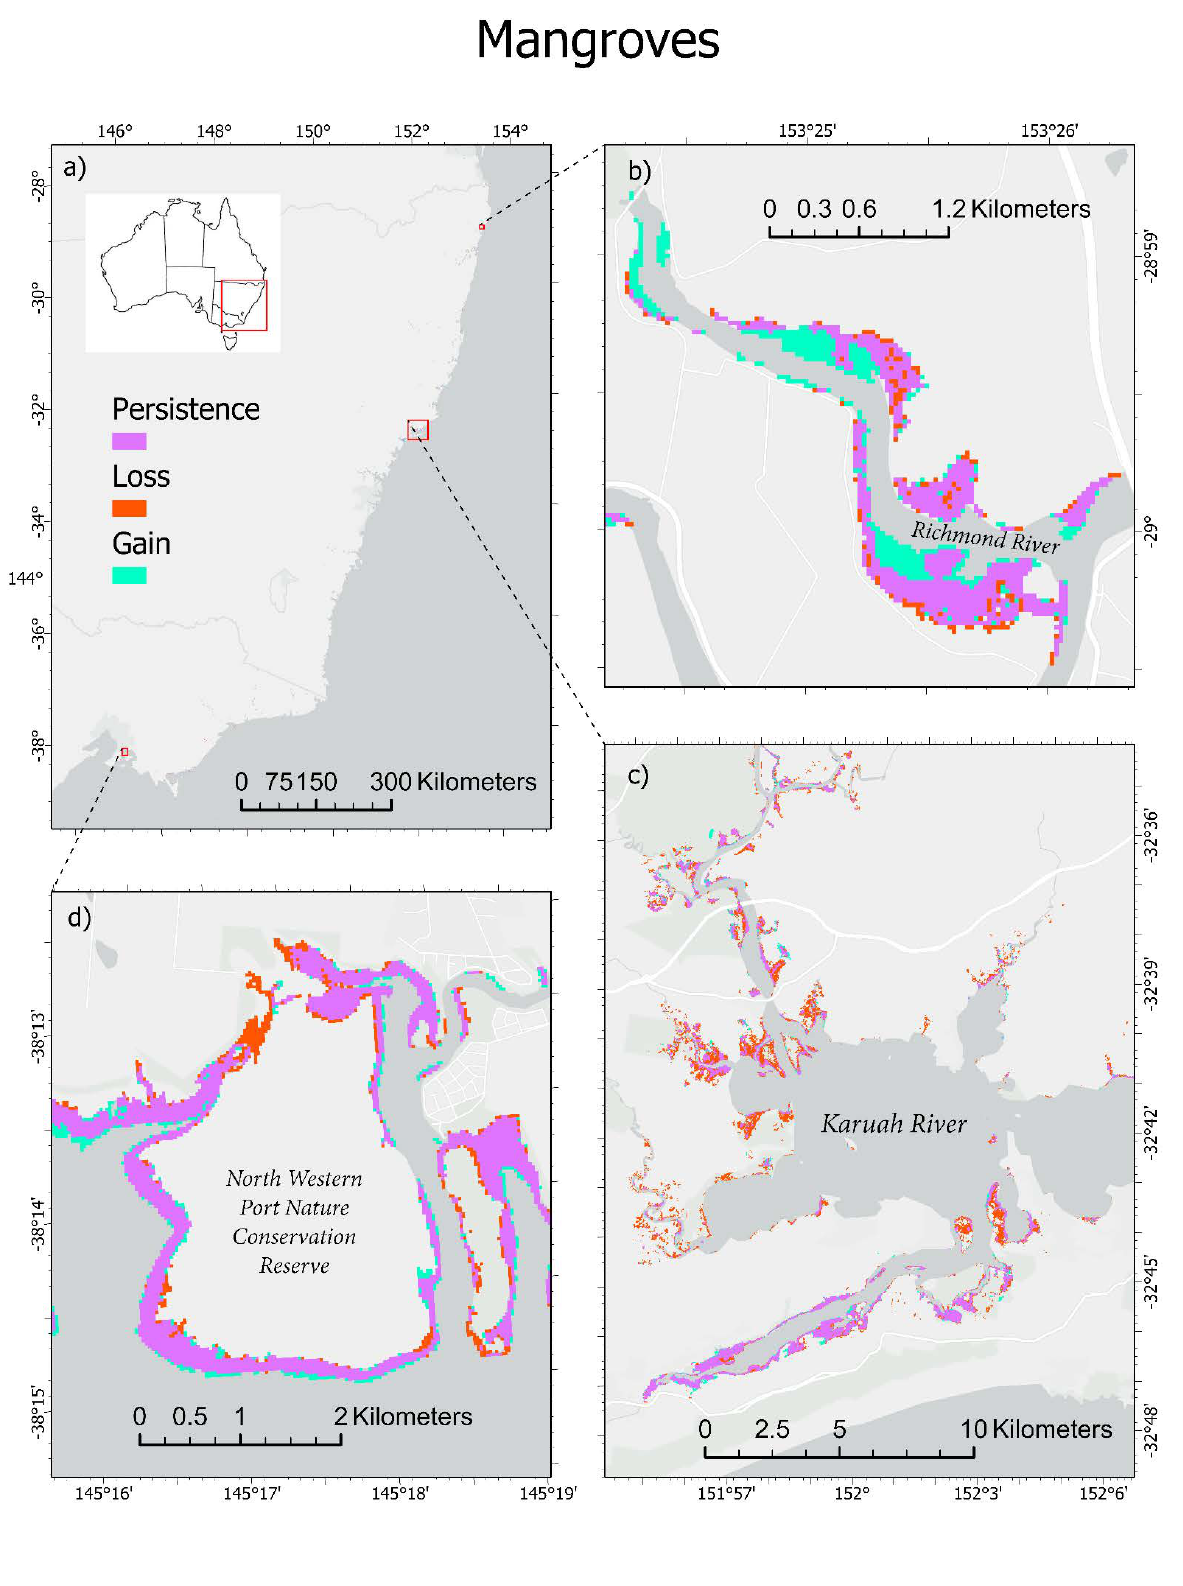
Figure 3. Mangrove gains, losses, and persistence between 1991 and 2015 across the south-eastern coast of Australia ( a ), along with several zoomed-in examples ( b – d